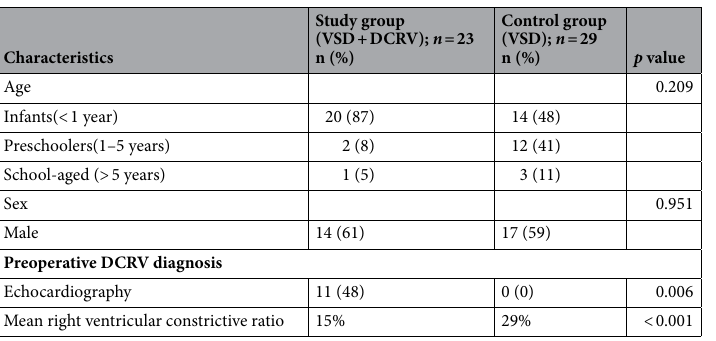
Table 1. Patient demographics. CT computed tomography; DCRV double-chambered right ventricle; VSD ventricular septal defect.